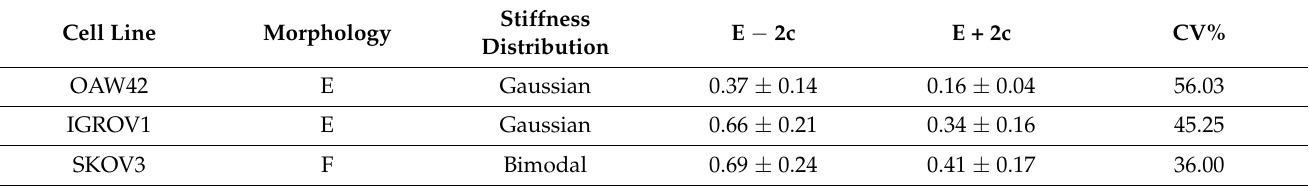
Table A1. Average Young’s modulus of cell lines before (E − 2c) and after (E + 2c) 2c treatment and corresponding coefficient of variation (CV%). F: Fibroblast, E: